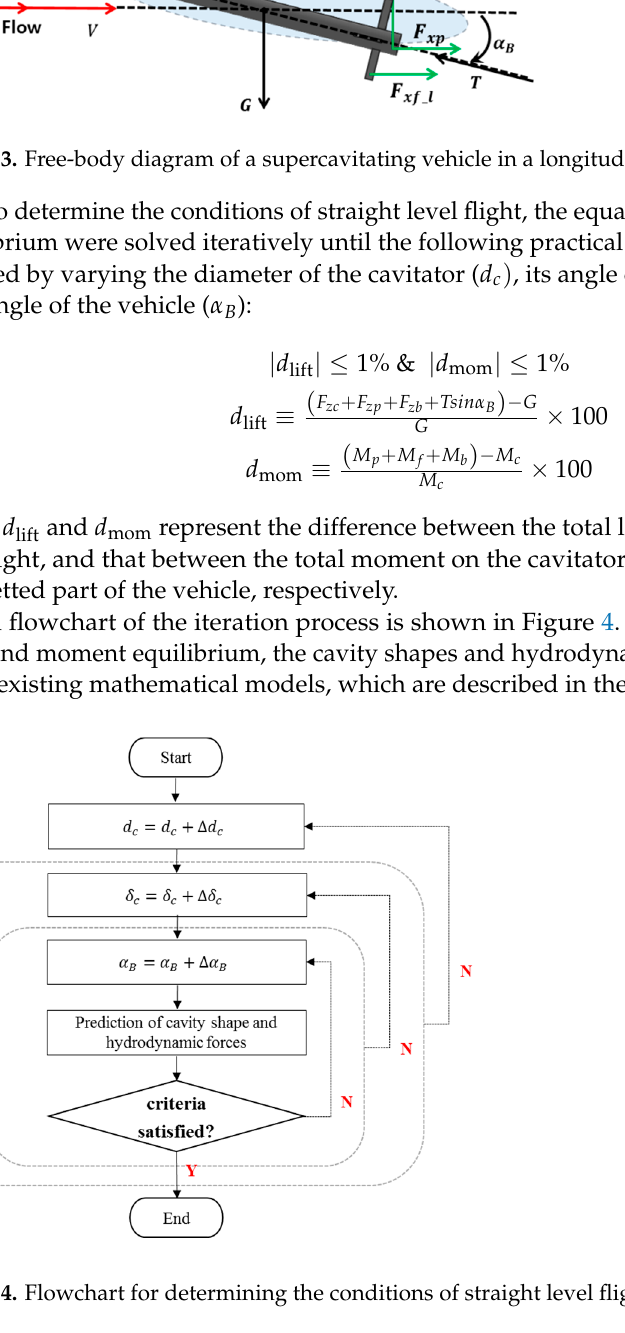
Figure 3. Free-body diagram of a supercavitating vehicle in a longitudinal vertical plane. where 𝐹 (cid:3051)(cid:3030) , 𝐹 (cid:3053)(cid:3030) , and 𝑀 (cid:3030) represent the hydrodynamic drag, lift, and the sum of their mo-